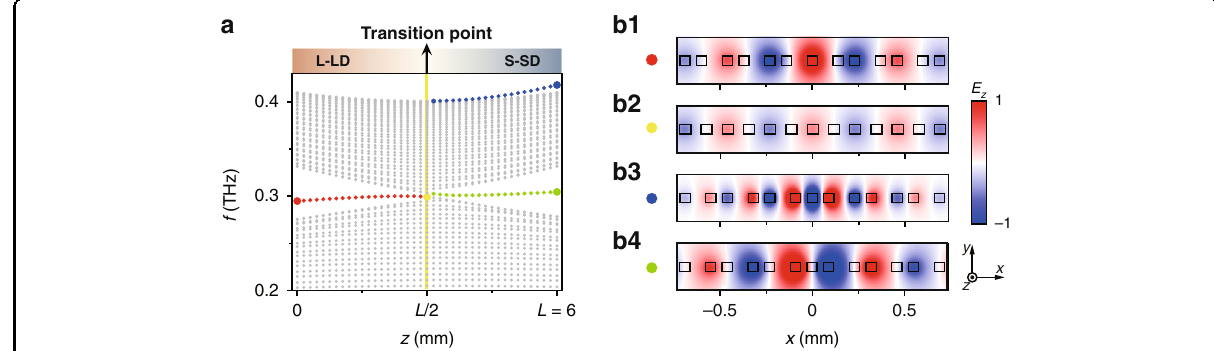
Fig. 2 Eigenvalues and representative eigenmode distributions in the SSH-type LN topological structure. a Calculated eigenvalue distribution of the microstructure along the z -axis. The yellow line represents the equidistant structure at z = L /2 ( d 1 = d 2 = 55 μ m), which marks the phase transition point. The left side of the yellow line ( z < L /2) is the L-LD region, where topological defect modes are denoted by red dots. The right side ( z > L /2) indicates the S-SD region, where topologically nontrivial and trivial defect modes are marked by green and blue dots, respectively. Gray dots represent the bulk modes. b1 Topological defect mode around 0.3 THz in the L-LD structure at z = 0. b2 The mode around 0.3 THz in the equidistant structure at z = L /2. b3 , b4 Topological trivial mode around 0.42 THz ( b3 ) and nontrivial mode around 0.3 THz ( b4 ) in the S-SD structure at z =